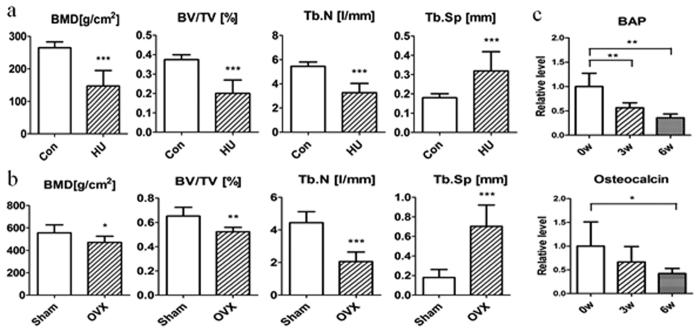
Characterization of bone phenotypes in two osteoporotic models.(a) The effects of hindlimb-unloading for 4 W on BMD and trabecular microarchitecture by determining with μCT (n = 6). (b) The effects of ovariectomy for 8 W on BMD and trabecular microarchitecture by determining with μCT (n = 6). (c) BAP and osteocalcin were detected in the serum of rhesus monkeys after bedrest for 0 w, 3w and 6 w (n = 6). All data are presented as mean ± SD. *p < 0.05, **p < 0.01, ***p < 0.001.